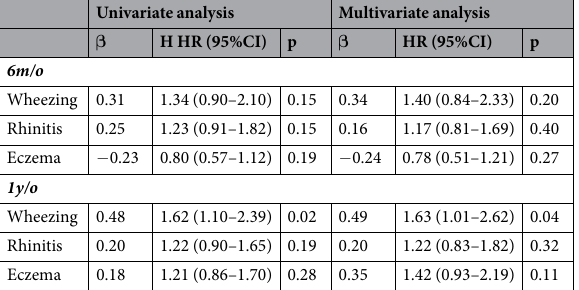
Table 2. Association between mode of delivery and allergic disorders during infancy 6m/o : 6 months old 1y/o: 1 year